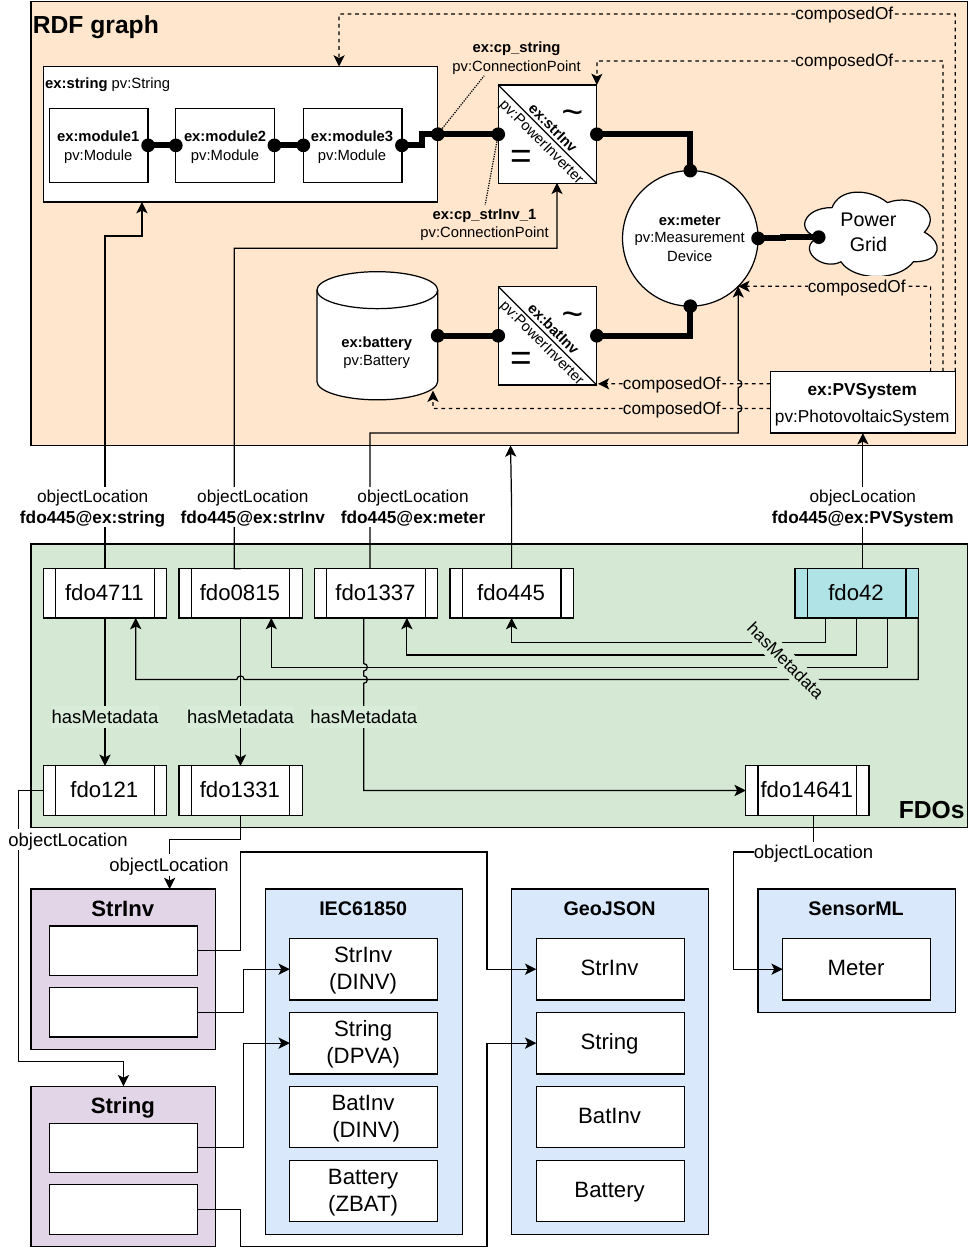
Figure 4. Diagram of the Modeling Concept using the Exemplary PV System from Figure